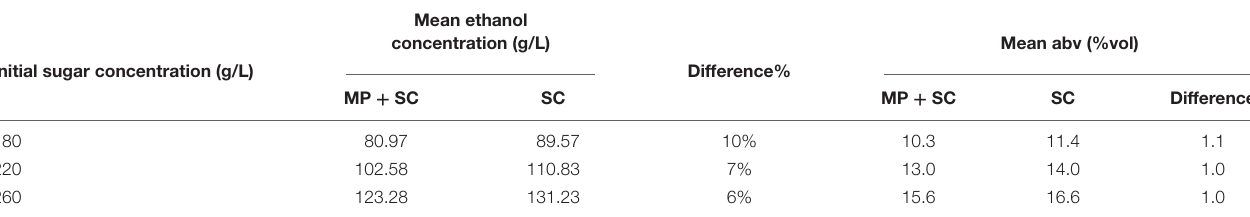
TABLE 4 | Concentrations of ethanol in g/L and in %vol at the end of fermentation under sequential inoculation (MP + SC) or in pure culture (SC) depending on the initial sugar concentration in the medium. Mean ethanol concentration (g/L)